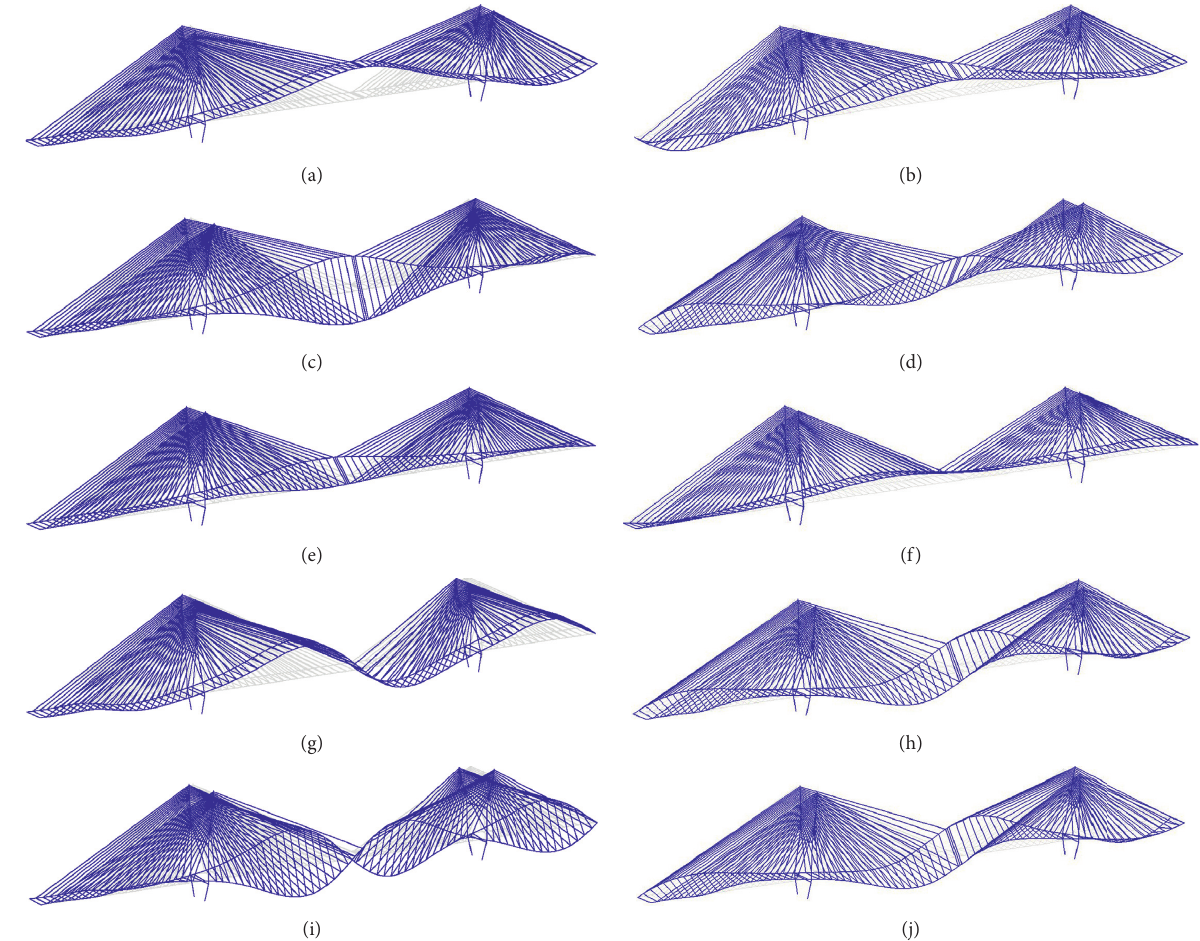
Figure 12: Mode shapes for intact and damaged cases. (a) 1 st mode for intact case (1.13Hz). (b) 1 st mode for damaged case (0.98Hz). (c) 2 nd mode for intact case (1.44Hz). (d) 2 nd mode for damaged case (1.33Hz). (e) 3 rd mode for intact case (1.51Hz). (f) 3 rd mode for damaged case (1.5Hz). (g) 4 th mode for intact case (1.67 Hz). (h) 4 th mode for damaged case (1.57Hz). (i) 5 th mode for intact case (2.13Hz). (j) 5 th mode for damaged case (1.94Hz).